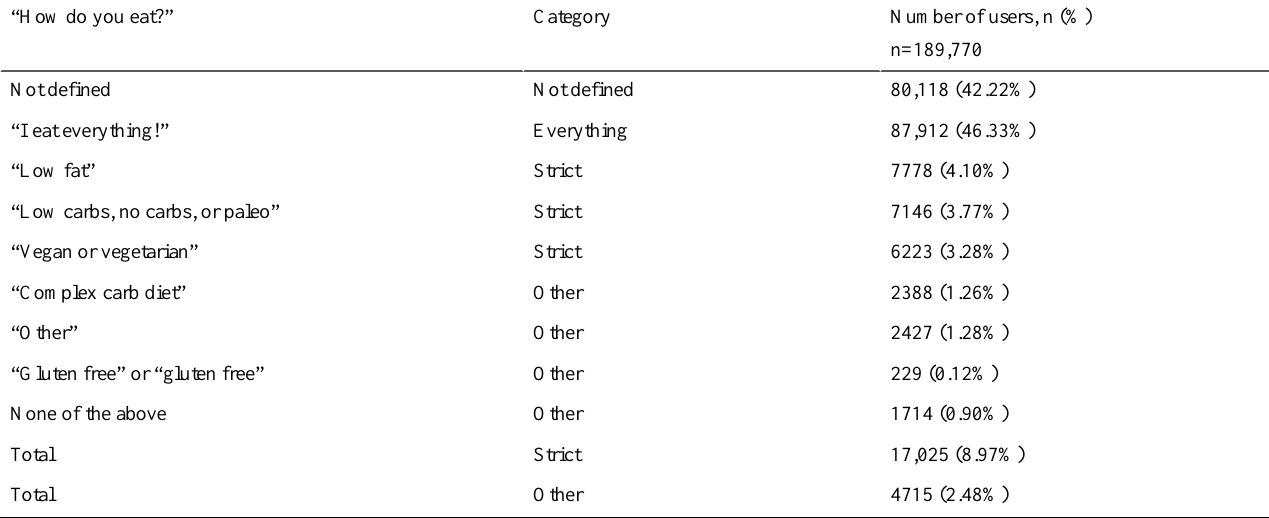
Table 2. Numbers of users according to their dietary preferences based on “How do you eat?” question.